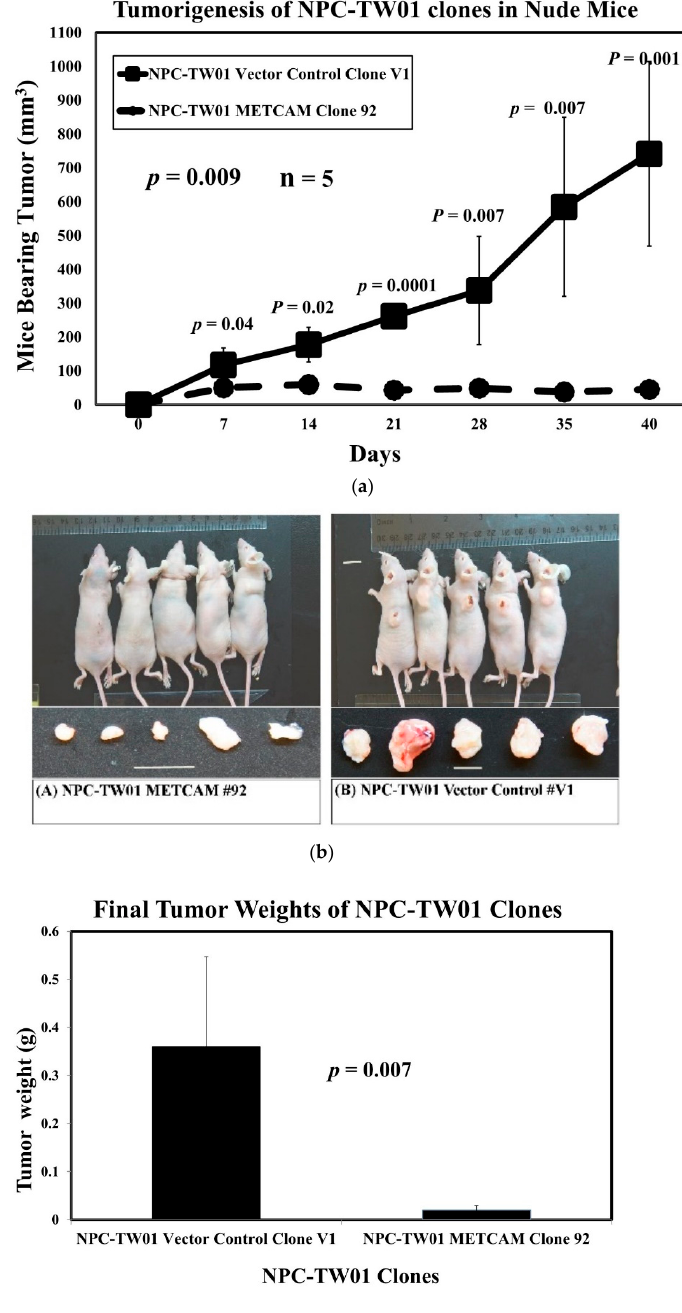
Figure 5. Effects of huMETCAM/MUC18 ′ s over-expression on in vivo tumorigenesis. Tumorigenicity of the METCAM clone #92 and the vector control clone #V1 of the NPC-TW01 cells was determined by subcutaneous injection of the cells from each clone at the dorsal side in male athymic nude mice. ( a ) The tumor proliferation by the two clones by plotting mean tumor volumes/weights versus time after injection is shown. p -values were determined between tumor volumes through the time course of the METCAM clone #92 and that of the vector control clone V1. ( b ) The mice bearing tumors of the METCAM clone #92 and the vector control clone V1 and the excised tumors are shown. ( c ) The mean final tumor weights of the two clones in the athymic nude mice were compared at the endpoint. Both the mean final tumor weights from five mice of the vector control clone V1 were statistically significantly heavier than the mean tumor weights from those of the METCAM clone #92 since the p -value was 0.007.